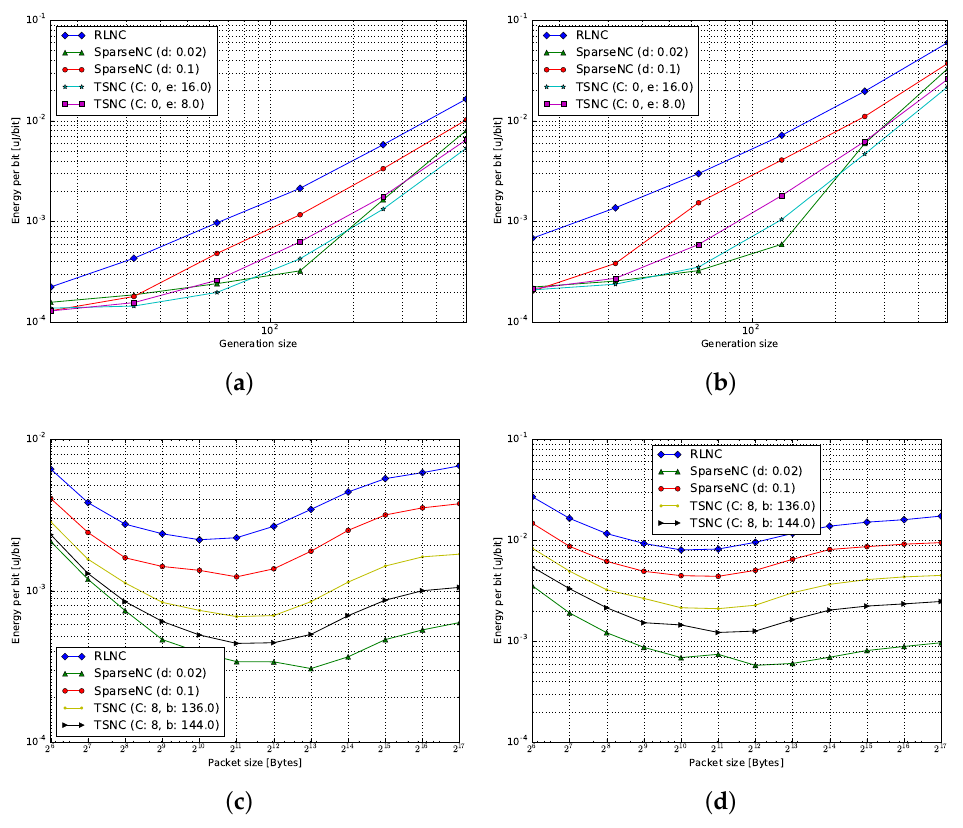
Figure 12. Decoder energy measurements for the Raspi 2. ( a ) Energy per bit vs. generation size for q = 2; ( b ) energy per bit vs. generation size for q = 2 8 ; ( c ) energy per bit vs. packet size for q = 2, g = 128; ( d ) energy per bit vs. packet size for q = 2 8 , g =